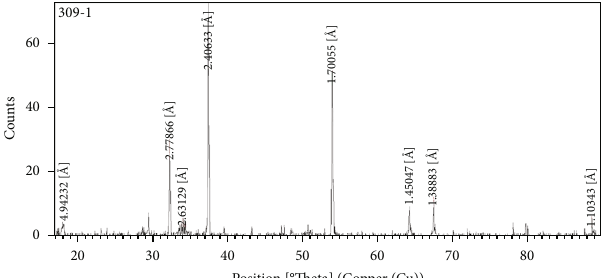
Figure 4: Mineralogical analysis of produced CaCO